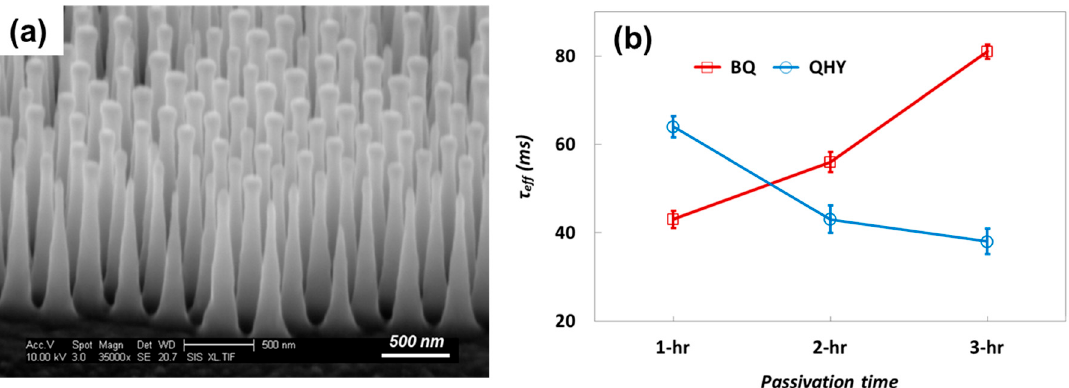
Figure 8. ( a ) Si nanostructure fabricated on 1-inch × 1-inch Si surface; and ( b ) measured τ eff after dipping in QHY/MeOH, BQ/MeOH and 10% HF solution.